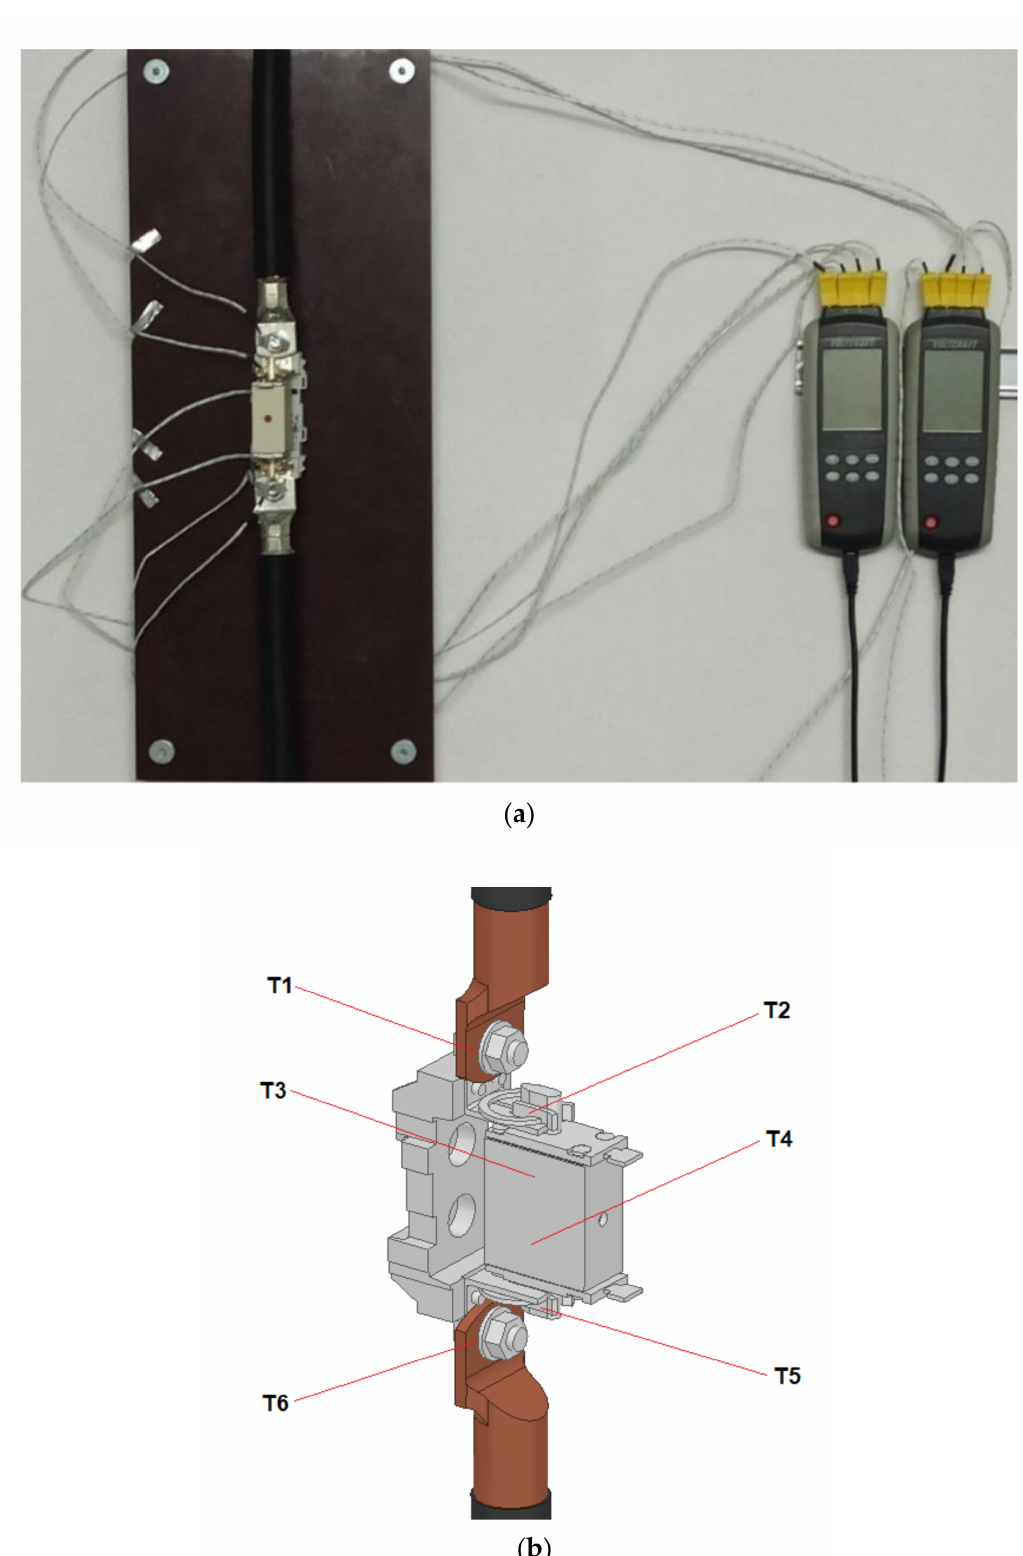
Figure 3. Fuse link with glued thermocouples (type K): ( a ) photo of the laboratory stand layout; ( b ) placement of ther- mocouples on the 3D fuse link model—T1, upper terminal; T2, upper electrical contact; T3, T4, fuse link body; T5, lower electrical contact; T6, lower